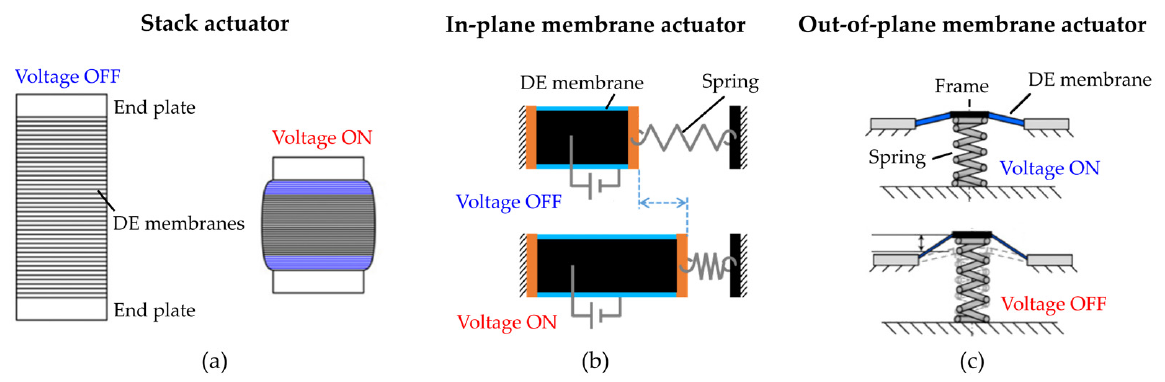
Figure 3. Different types of DEAs: stack actuator ( a ), in-plane membrane actuator ( b ), out-of-plane membrane actuator ( c ).